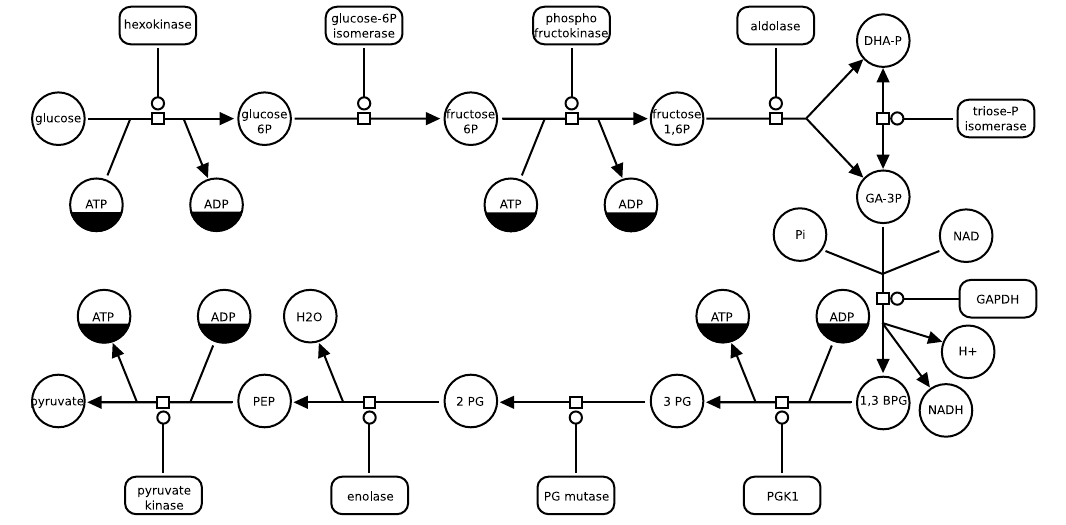
Figure A.1: Glycolysis. This example illustrates how SBGN can be used to describe metabolic